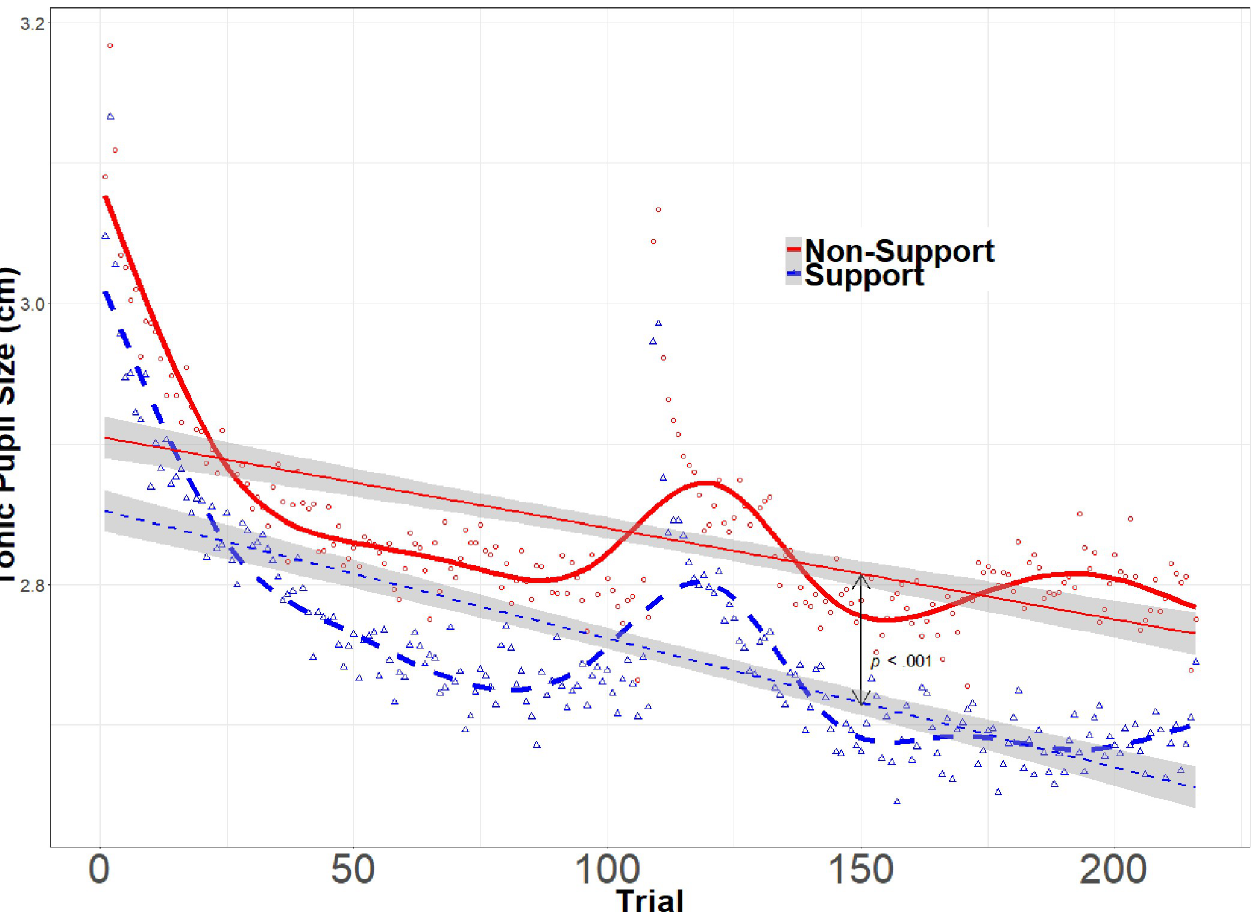
Fig 1. Change in tonic pupil size as a function of trial. Graph shows pupil size change in centimeters across all Stroop trials. The thicker, curved lines represent the raw data. The thinner, straight lines represent the linear function fit by the model. The small red circles and blue triangles represent the averaged data points for each trial by